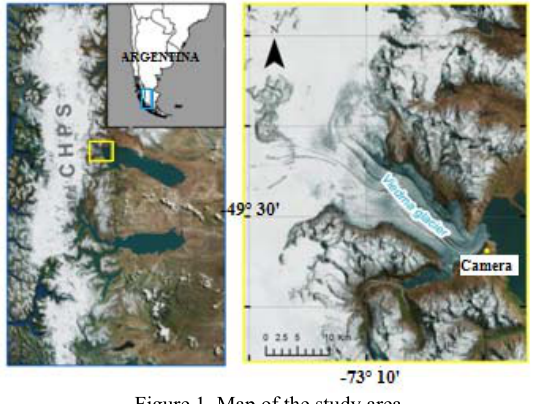
Figure 1. Map of the study area.